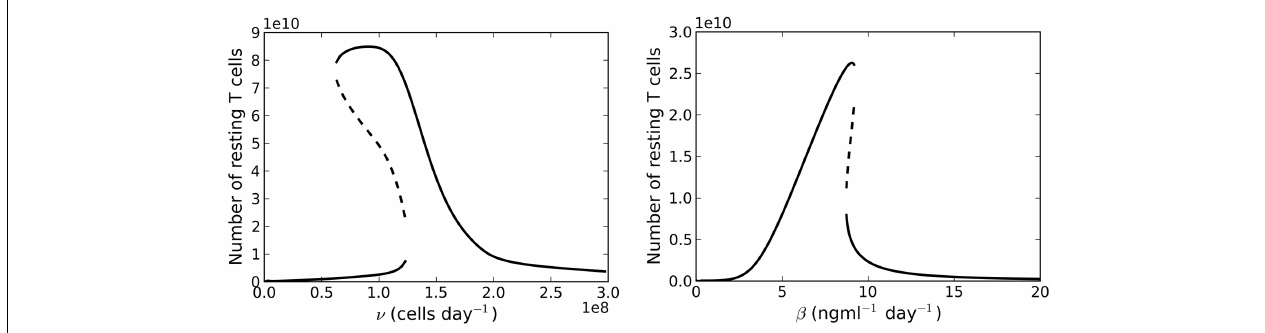
FIGURE 6 | Left panel: bifurcation diagram for varying the parameter v ( t ) for λ<µ C . Right panel: bifurcation plot as a function of varying the rate of IL-7 production.Thymic export is fixed at v (60years).